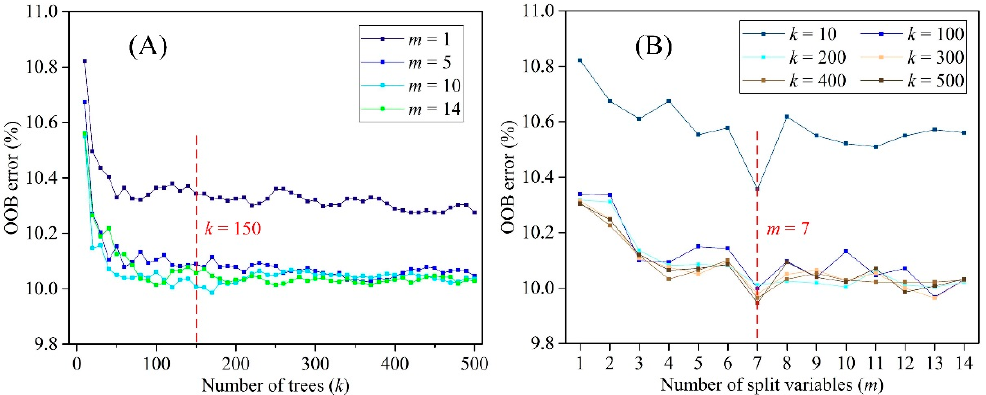
Figure 5. The settings for the RF classifier parameters number of trees ( A ) and number of split variables ( B ) based on the out-of-bag (OOB) error.